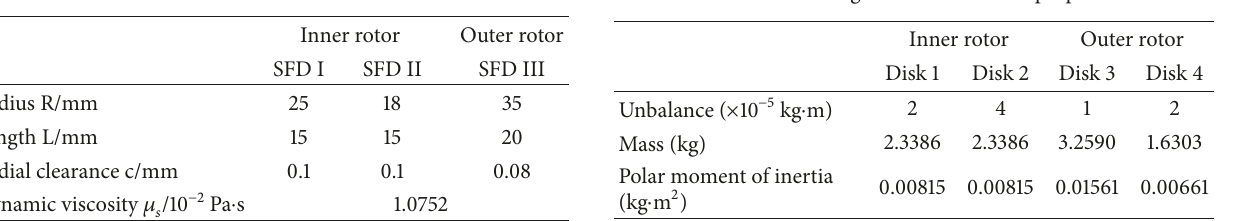
Table 4: Parameters of SFDs. Table 5: Unbalance configuration and inertia properties of